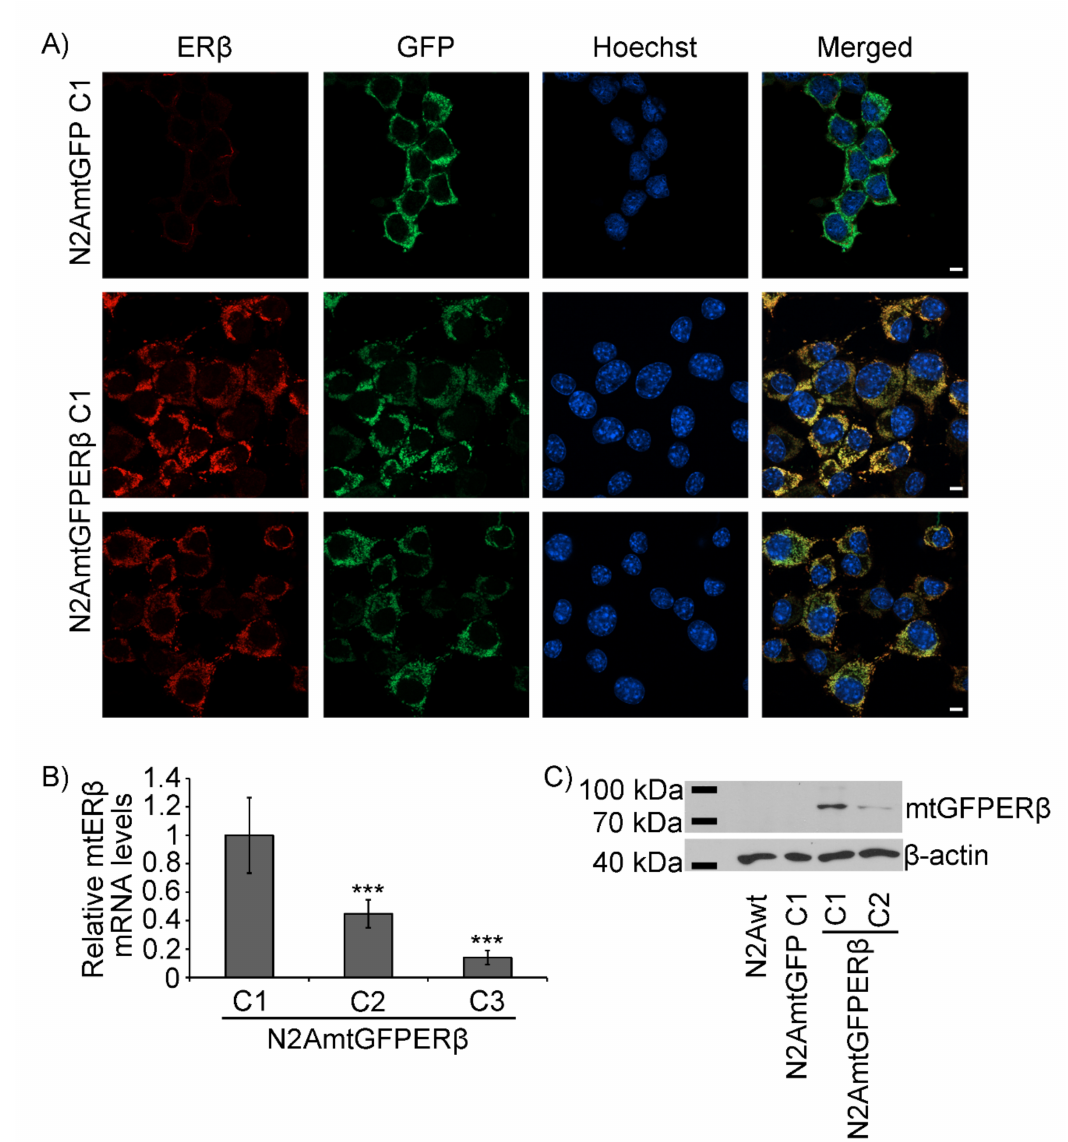
Figure 2. Verification of the mitochondrial ER β expression in N2AmtGFPE β cells. ( A ) Confocal colocalization studies in colony 1 of the N2AmtGFP and N2AmtGFPER β cells. Anti-ER β antibody and anti-mouse Alexa 568 secondary antibodies were applied for the ER β detection. Mitochondrial GFP fusion proteins are depicted in green. Nuclear Hoechst staining is depicted in blue. Bars indicate 10 µ m. ( B ) Results from real-time PCR analysis for the assessment of the relative human mRNA ER β levels in colonies of N2AmtGFPER β cells. β -actin was used as reference gene. The highest mRNA expression level in the respective colony of the N2AmtGFPER β was set as 1. Data are presented as the mean ± SD; *** p < 0.001 ( n = 4–5), compared to colony 1. ( C ) Western blot analysis of mtGFPER β , in N2A and in colonies of N2AmtGFP and N2AmtGFPER β cells. Anti-ER β and anti- β -actin antibodies were used for ER β and β -actin